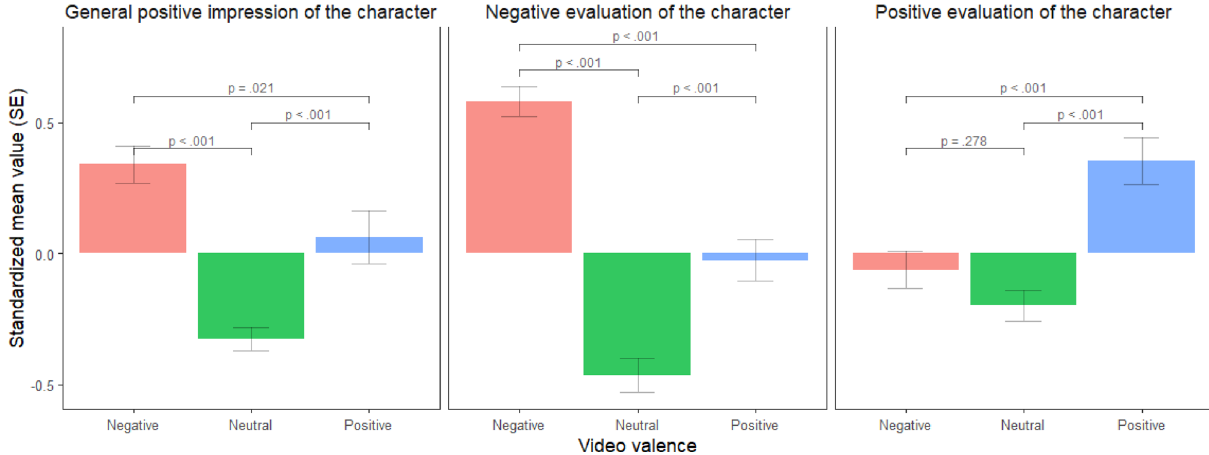
Figure 2. The effect of manipulation by valence